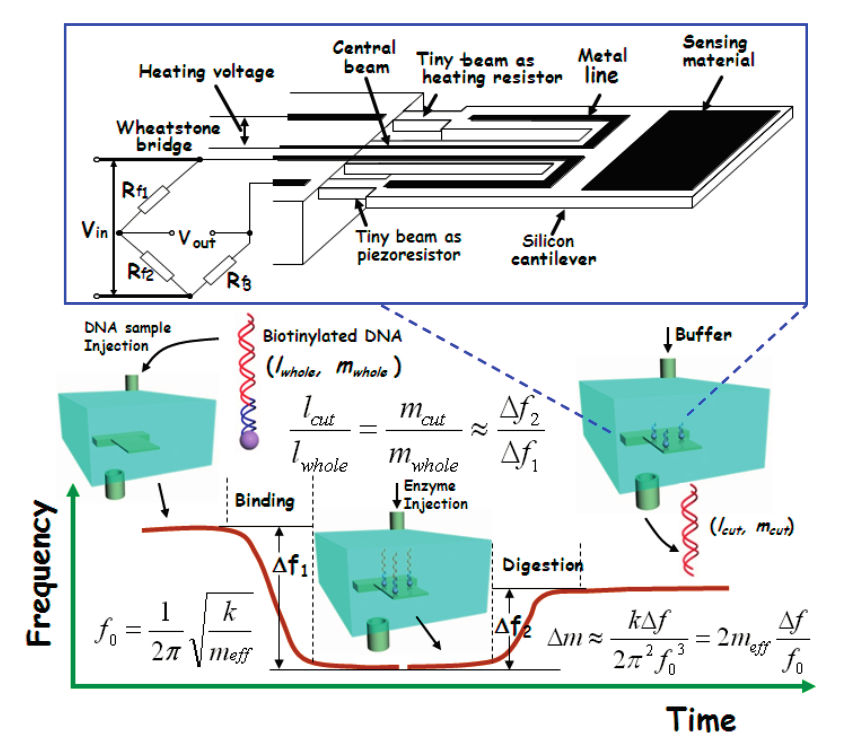
Figure 15. Schematic and procedure for direct identification of double-strand DNA. The in-plane mode resonant cantilever is embedded in a microfluidic chip for real-time DNA detection. The biotin-labeled DNA sample is specifically bound to the cantilever surface via specific binding with pre-immobilized streptavidin. Then, the adsorbed double-strand DNA can be site-specific digested by restriction-enzyme and the corresponding segment of the double-strand chain is cut-off. Two frequency-shift signals can be readout for the DNA binding induced mass increase and the subsequent mass loss due to enzyme digestion, respectively. The two signals can be used for calculating the specific restriction site, thereby directly identifying the double-strand DNA. Reprinted with permission from